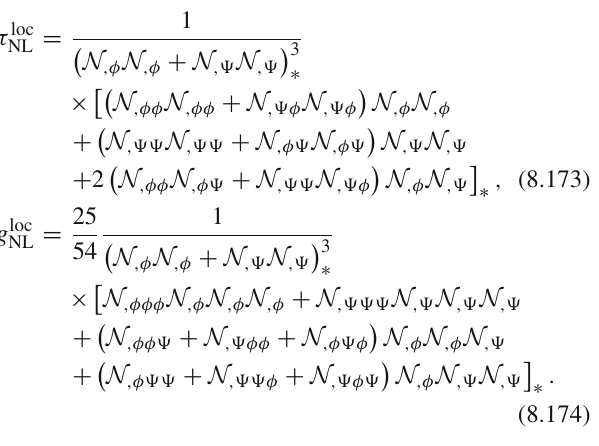
four point non-Gaussian amplitude from equilateral configuration without assuming Suyama–Yamaguchi consistency